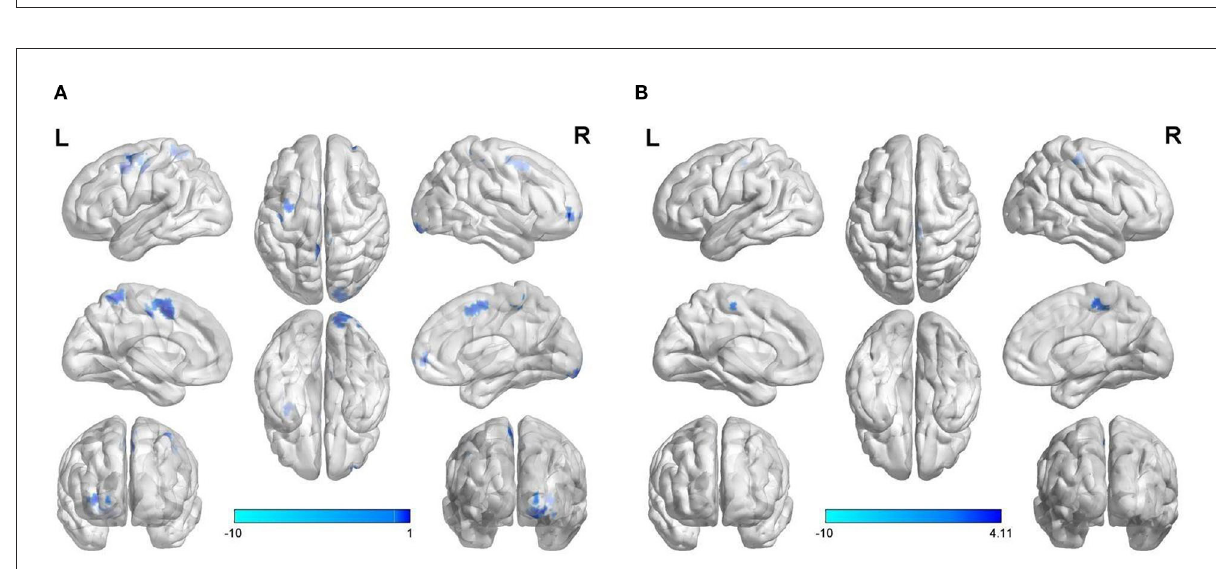
FIGURE3 Abnormal voxel-wise functional connectivity with regions of abnormal ReHo (A) and DC (B) as seed points.